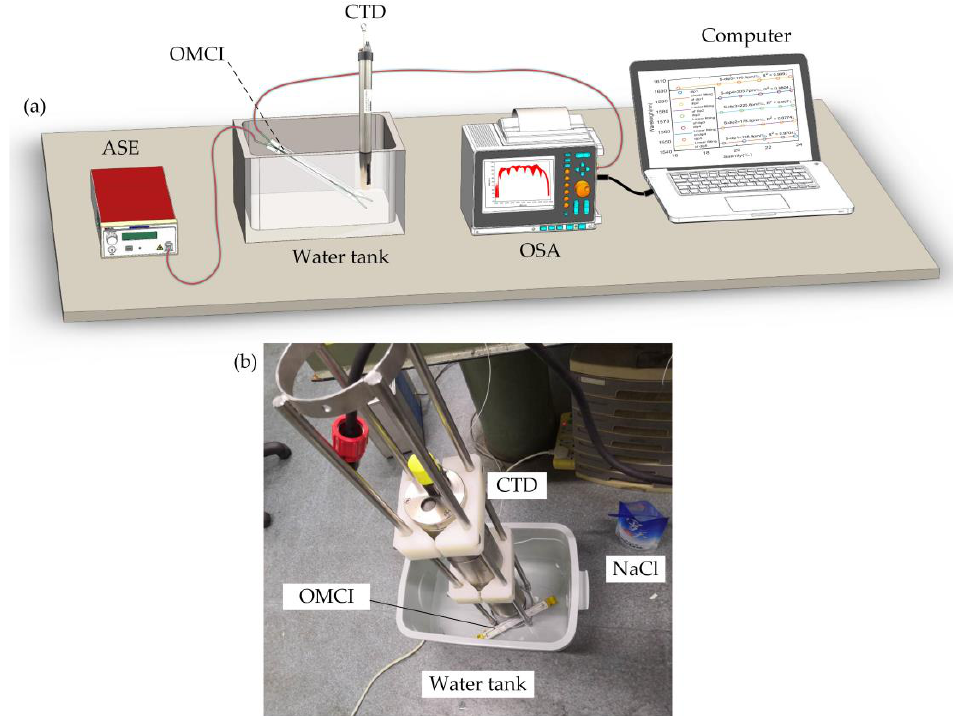
Figure 7. ( a ) The schematic diagram of the experimental system, and ( b ) the salinity measuring experimental setup.